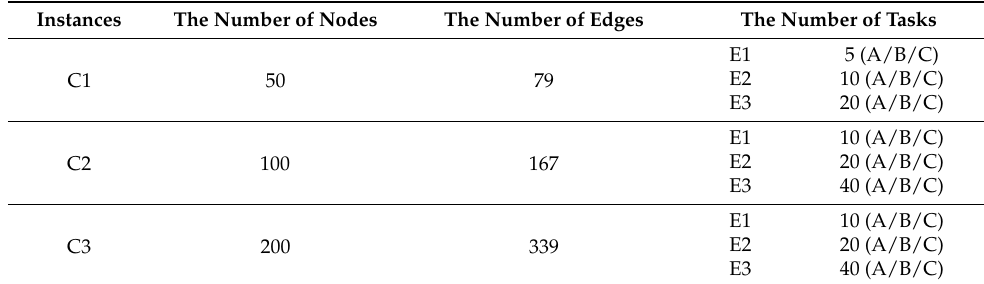
Table 2. The scale of the instances.